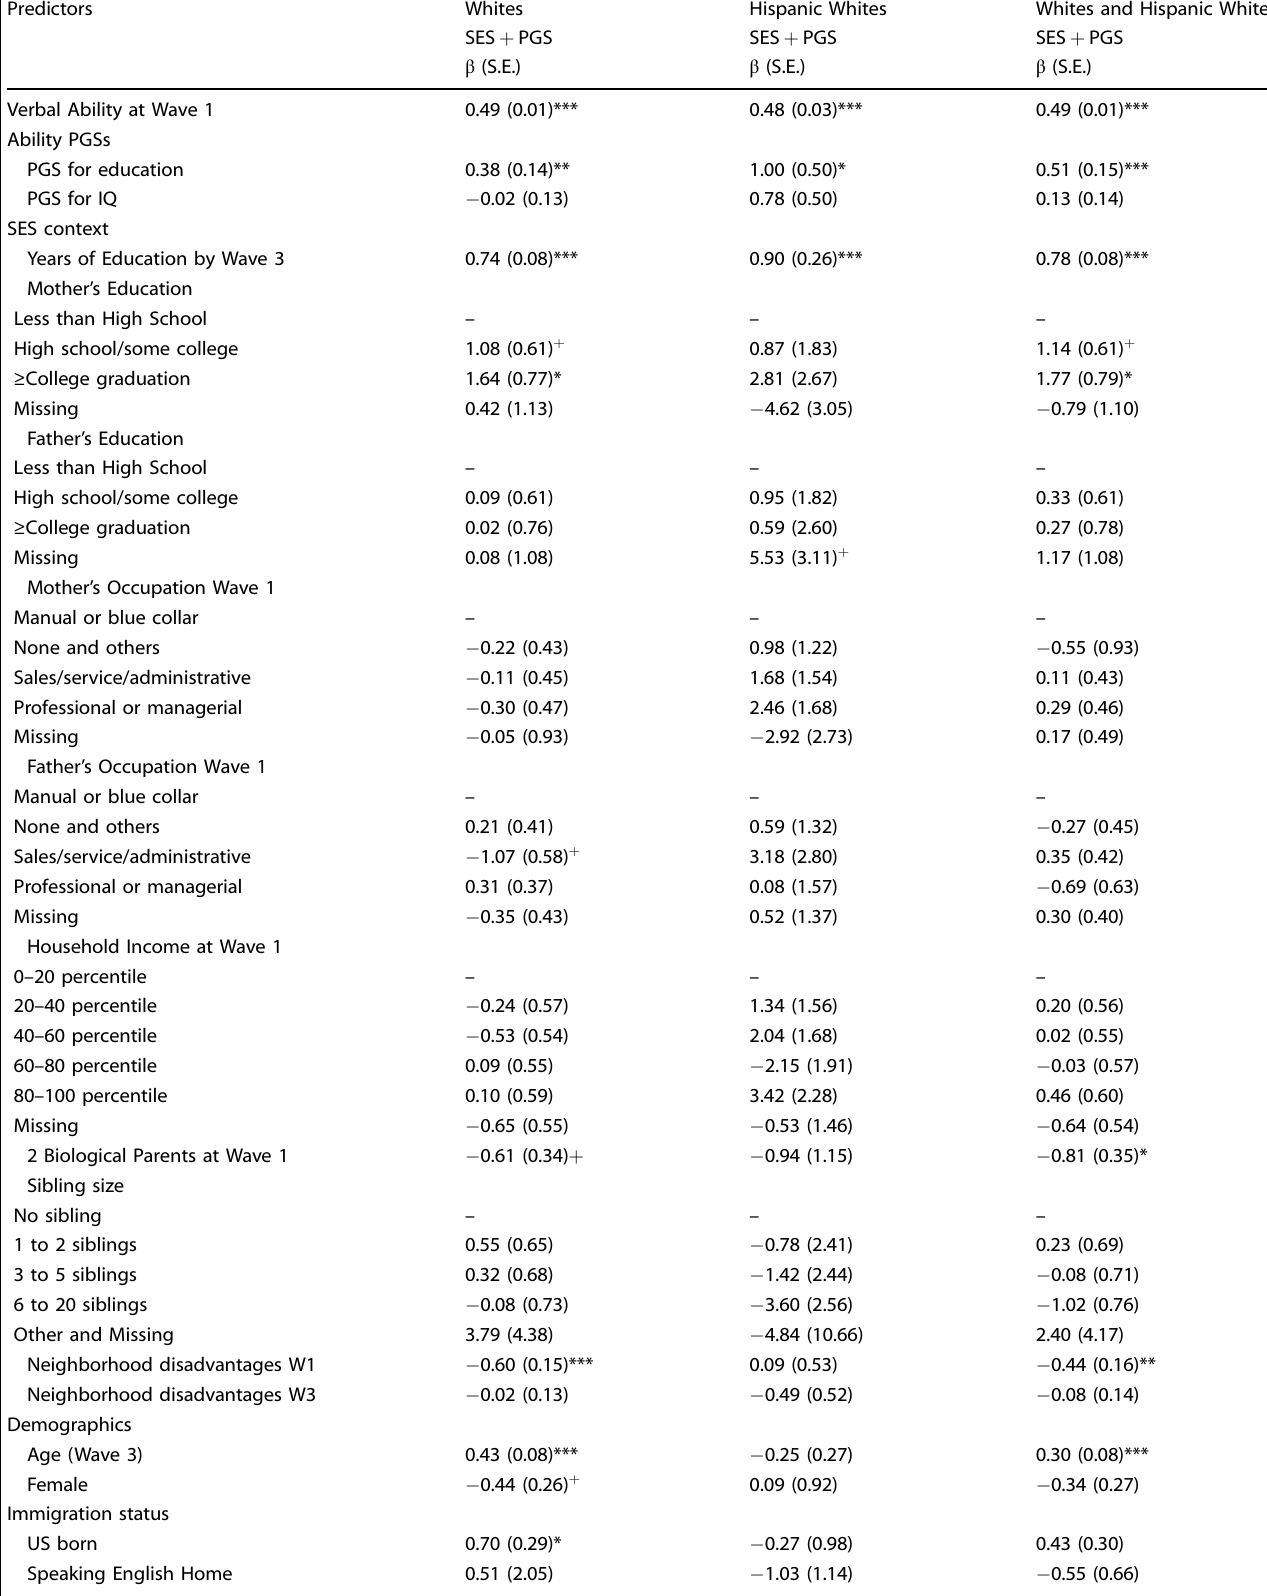
Table 5. Multilevel models of Wave-3 verbal ability showing coef fi cients (standard errors) of SES context and ability-related PGSs conditional on Wave-1 verbal